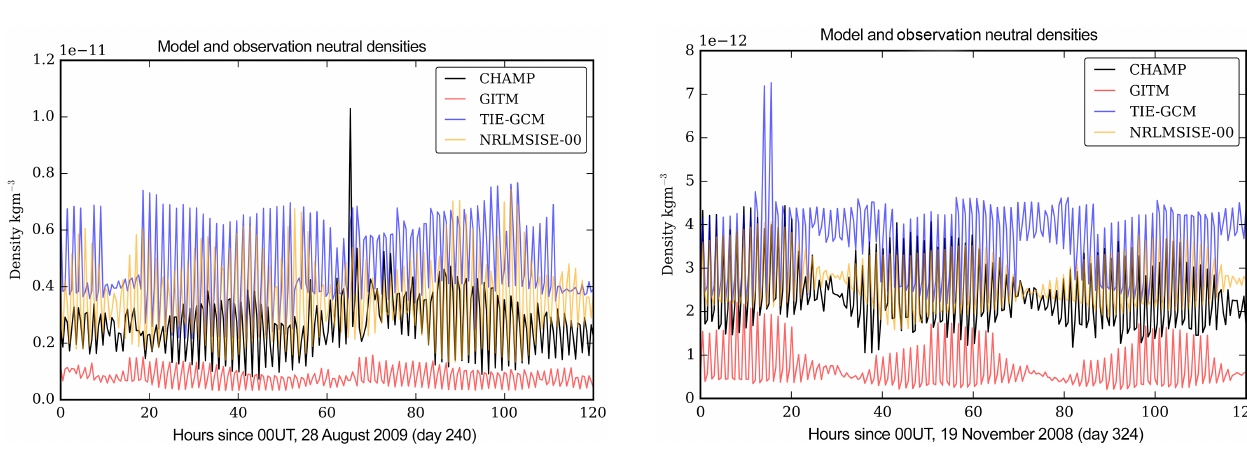
Figure 3. CHAMP, GITM, TIE-GCM, and NRLMSISE-00 reported neutral densities for the first test scenario (2009; solar minimum). The fast oscillations are due to CHAMPs orbit ( ∼ 90min).